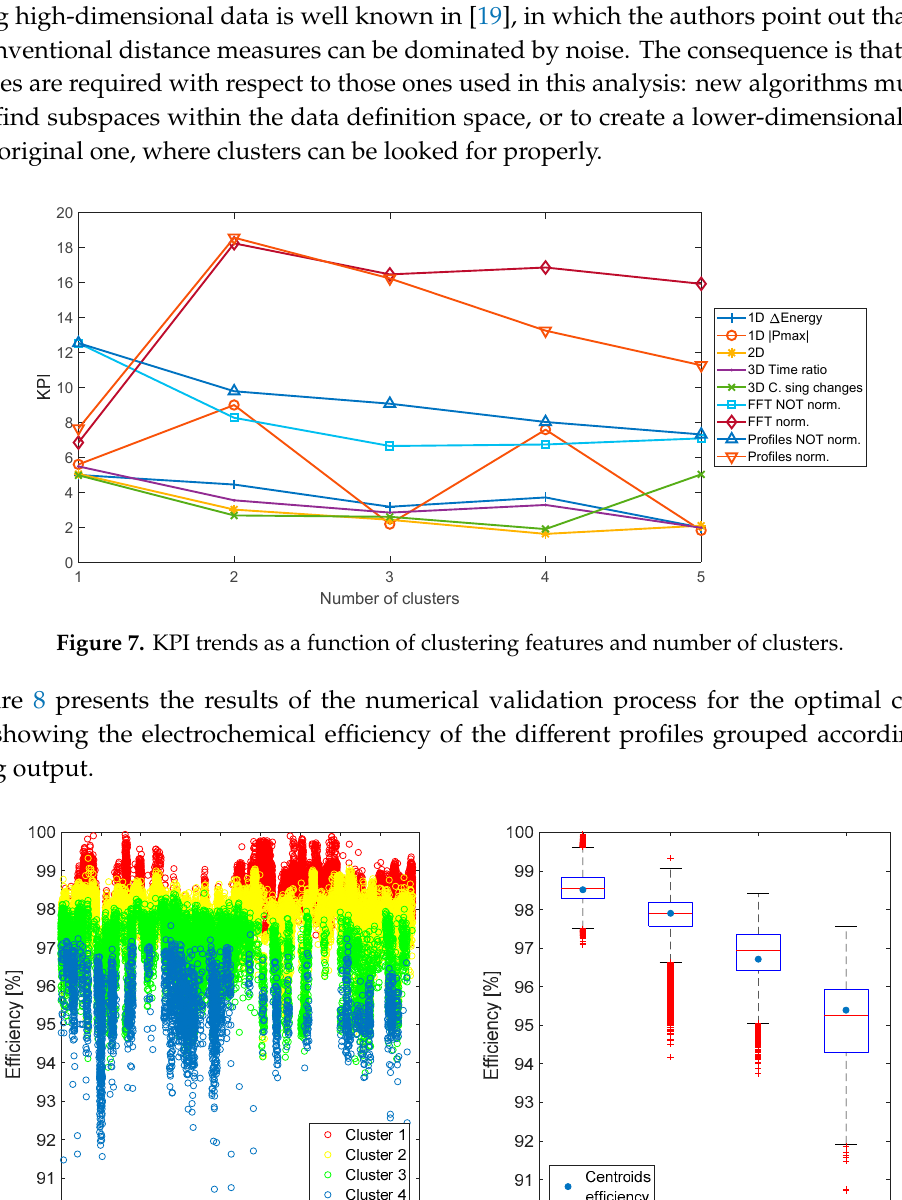
Figure 9. Regions of the Pmax and Δ Energy plan that belong to the different clusters.